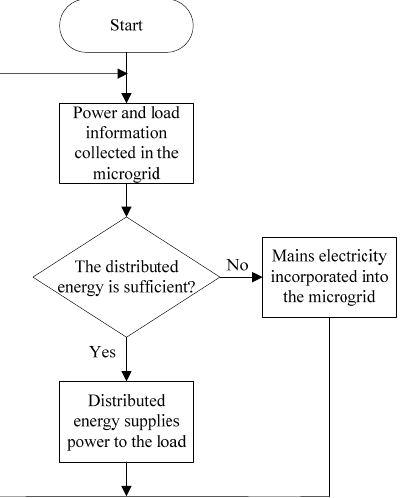
Figure 9. Flowchart of the distributed energy as the primary power supply mode